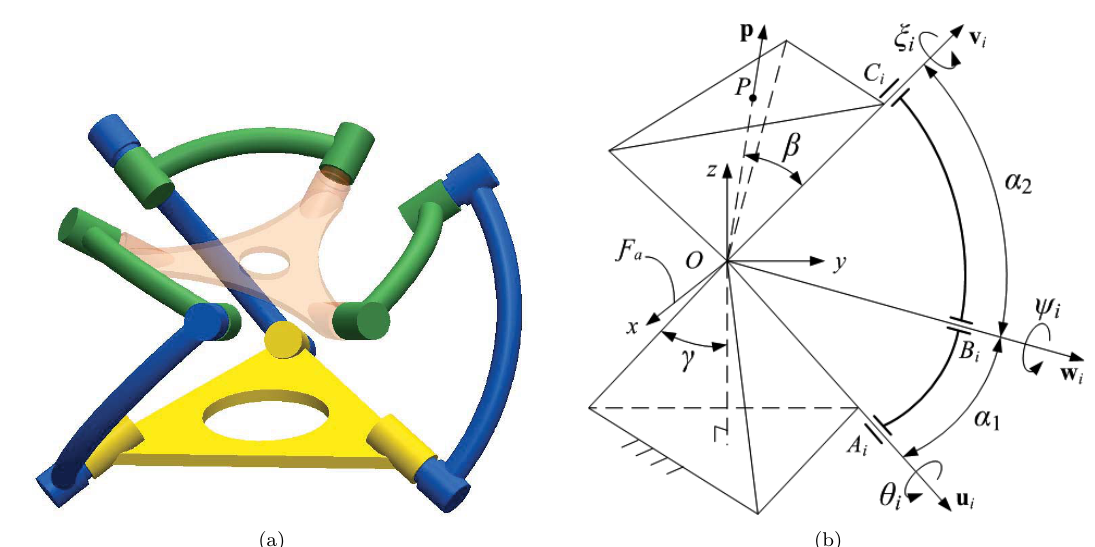
Figure 2: Architecture of a general SPM: (a) overview, (b) parameterization of the i th